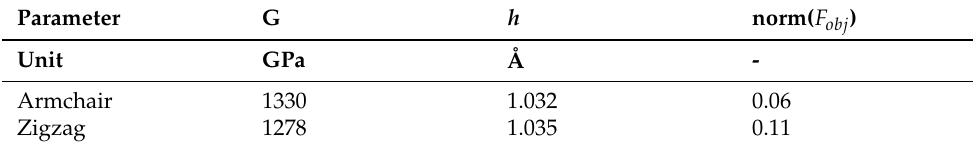
Table 4. Identified material parameters for armchair and zigzag CNTs as classical